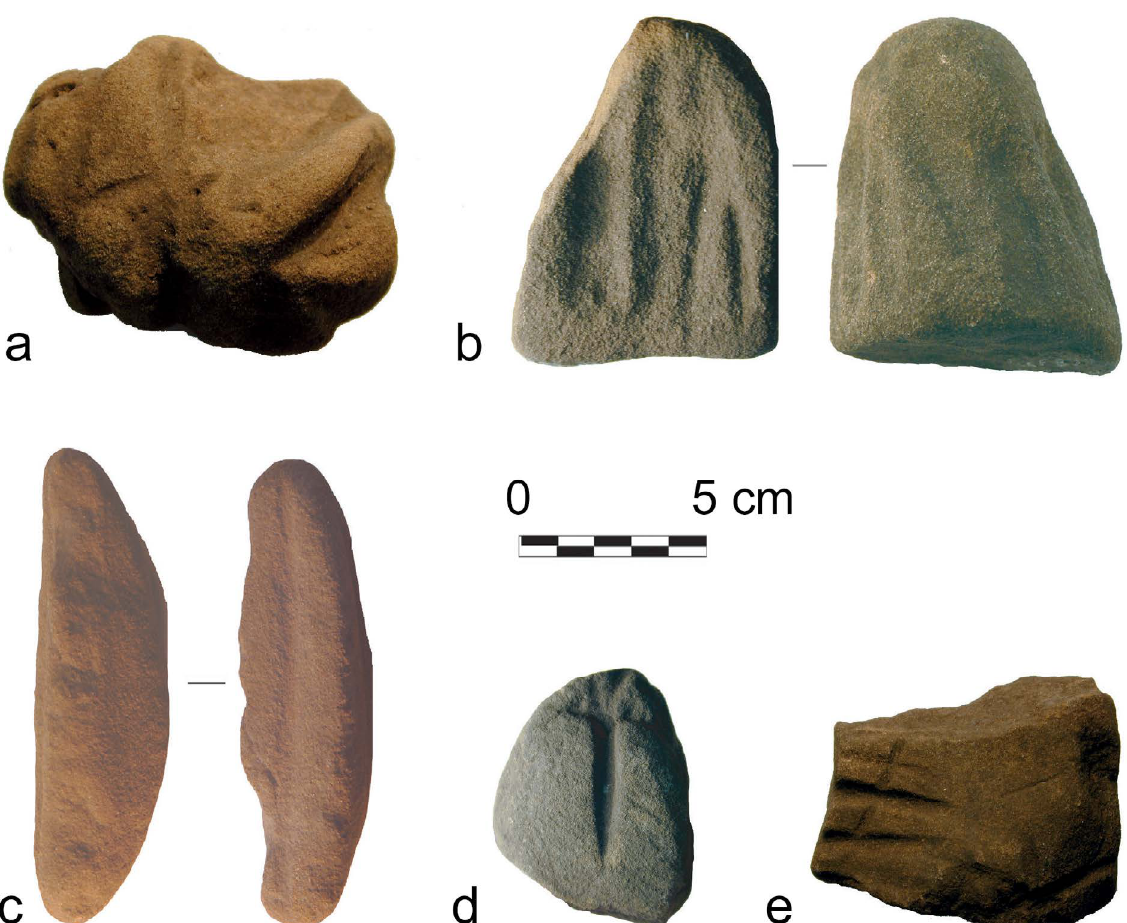
Figure 5. Different types of grooved abraders: a. and e. Bucy-le-Long “la Fosselle” (Aisne); b-c-d. Cuiry-les- Chaudardes “les Fontinettes” (Aisne).